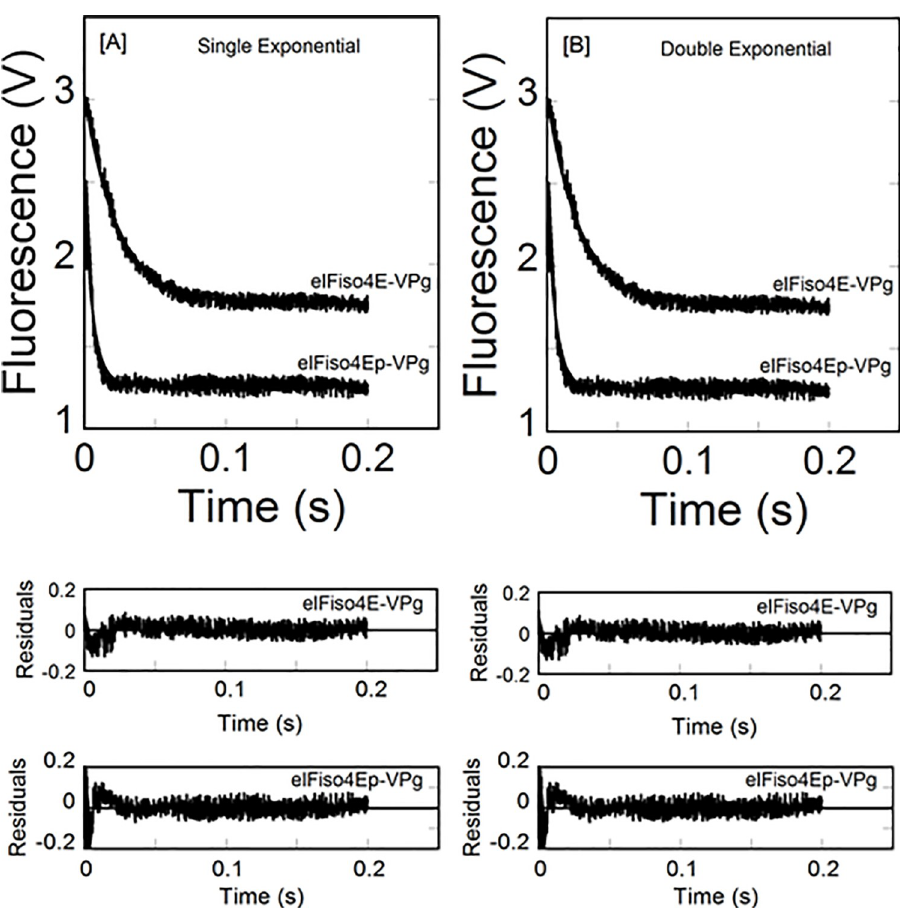
Fig 1. Phosphorylation enhances the kinetic rates for the binding of eIFiso4E with VPg. eIFiso4Ep or eIFiso4E (0.2 μ M) in one syringe was mixed with VPg (2.0 μ M) in the other syringe at 298 K. (A) Single-exponential fit to the kinetic data. (B) Double-exponential fit to the same kinetic data as in panel A. Solid lines represent the fitted curve drawn through the data points was best fit by assuming a single-exponential fit. Residuals for the corresponding fits are shown in the lower panels .